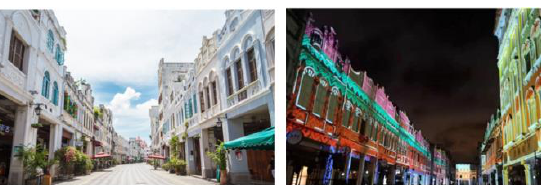
Table 1. Features and Advantages of